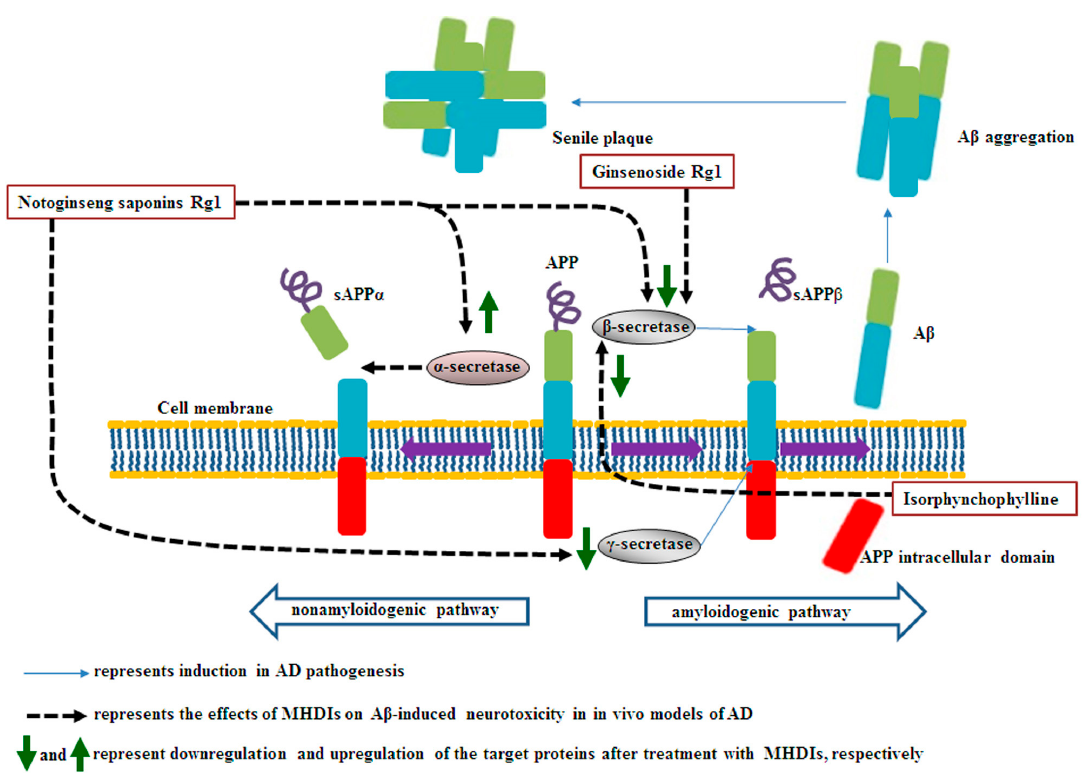
Figure 1. Schematic representation of the effects of MHDIs on A β accumulation in the hippocampus in the late phase of AD in in vivo models. sAPP, soluble amyloid precursor protein.